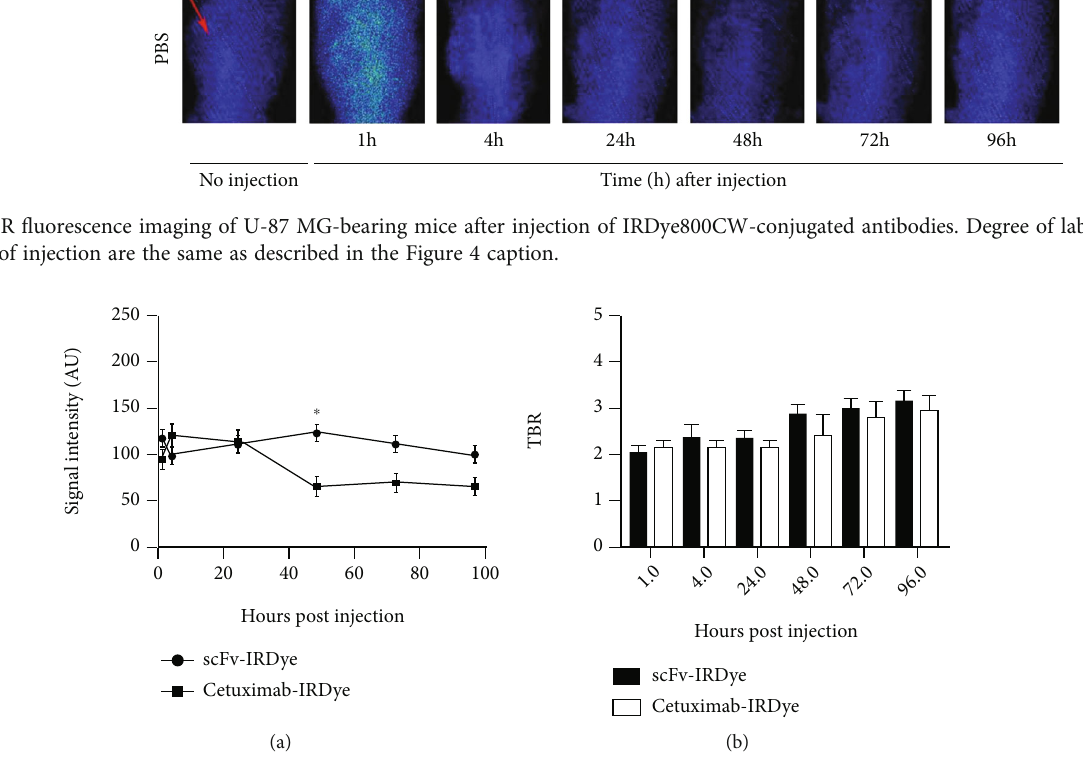
Figure 7: NIR fl uorescence analysis of U-87 MG tumors receiving IRDye800CW-conjugated antibodies. (a) Signal intensity 24 h after injection; both antibodies raised the same signal intensity. The maximum di ff erence in signal intensity occurred 48 h after injection; a signi fi cant di ff erence at statistical level of 5% ( ∗ p < 0 : 05 ). (b) Tumor-to-background ratio. There were no signi fi cant di ff erences in the ratios of cet.Hum.scFv-IRDye800CW and